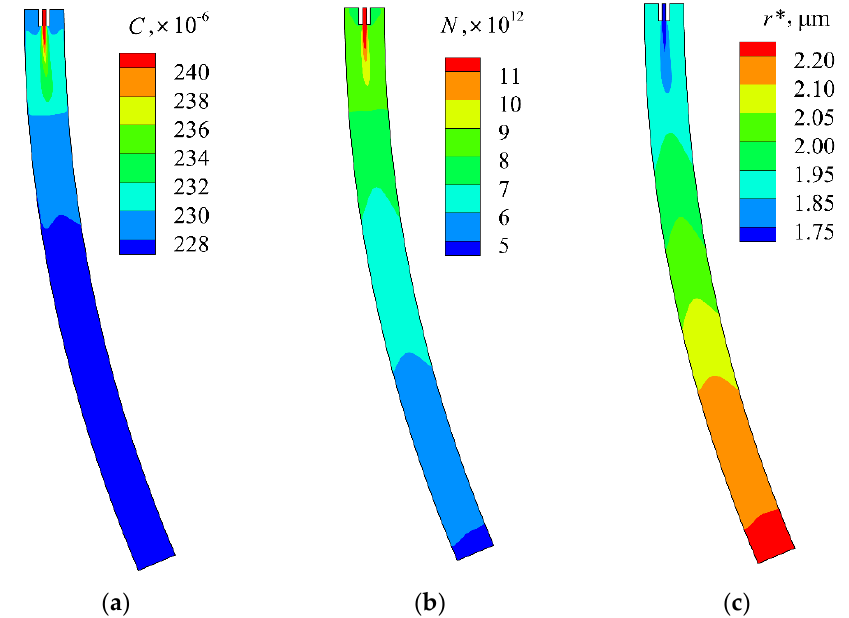
Figure 10. Inclusion distribution at vertical longitudinal-section in curved bloom continuous caster with M-EMS: ( a ) volume concentration; ( b ) number density; ( c ) characteristic radius.